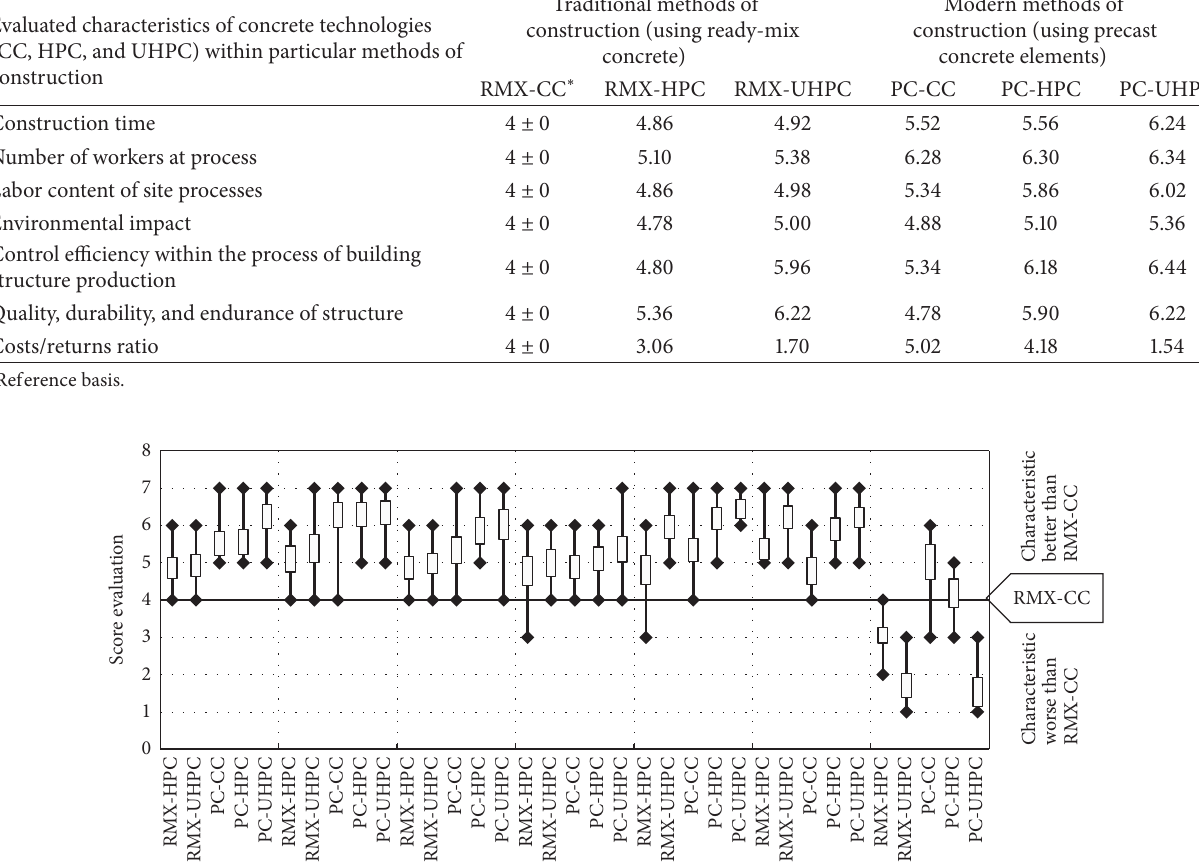
Table 2: Average score evaluation of characteristics of CC, HPC, and UHPC, respectively, compared with reference basis. Evaluated characteristics of concrete technologies (CC, HPC, and UHPC) within particular methods of construction